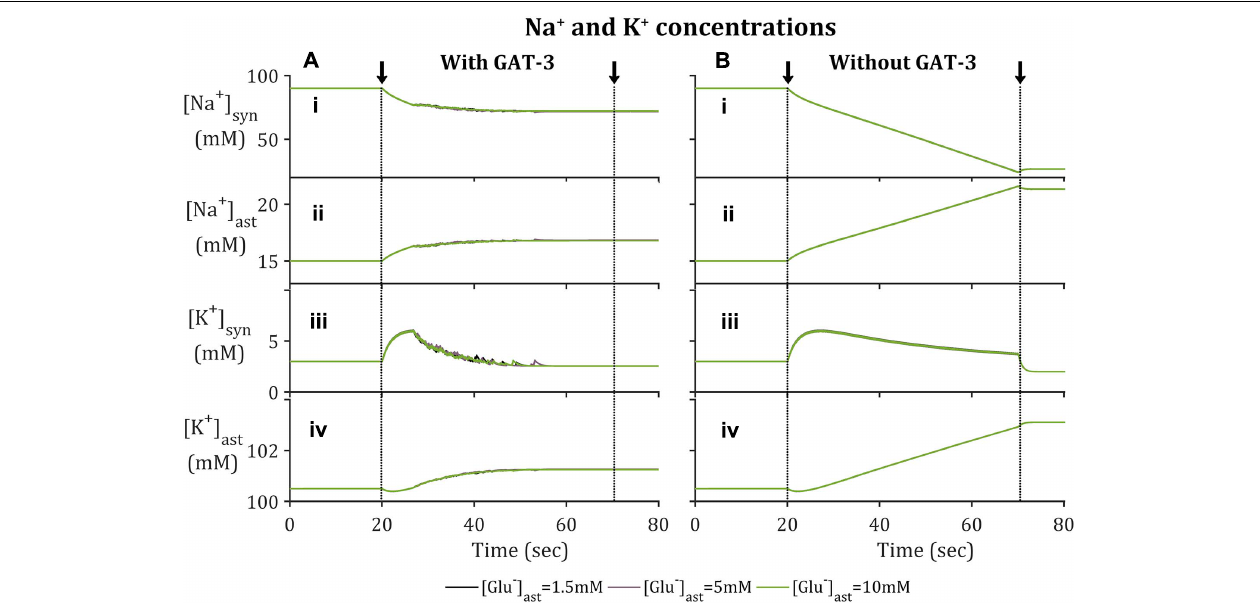
FIGURE 2 | Astrocytic and synaptic concentrations of Na + and K + where the model (A) includes GAT-3 activity and (B) where GAT-3 activity is not included; (i–iv) describes (respectively) synaptic Na + , astrocytic [Na + ], synaptic [K + ] and astrocytic [K + ]. The results show the ionic concentrations of a simulation in which the presynaptic neuron is subject to an applied current, pulsed at a frequency of 10 Hz over a 50 s window starting at 20 s (window of applied current given by arrows and dashed vertical